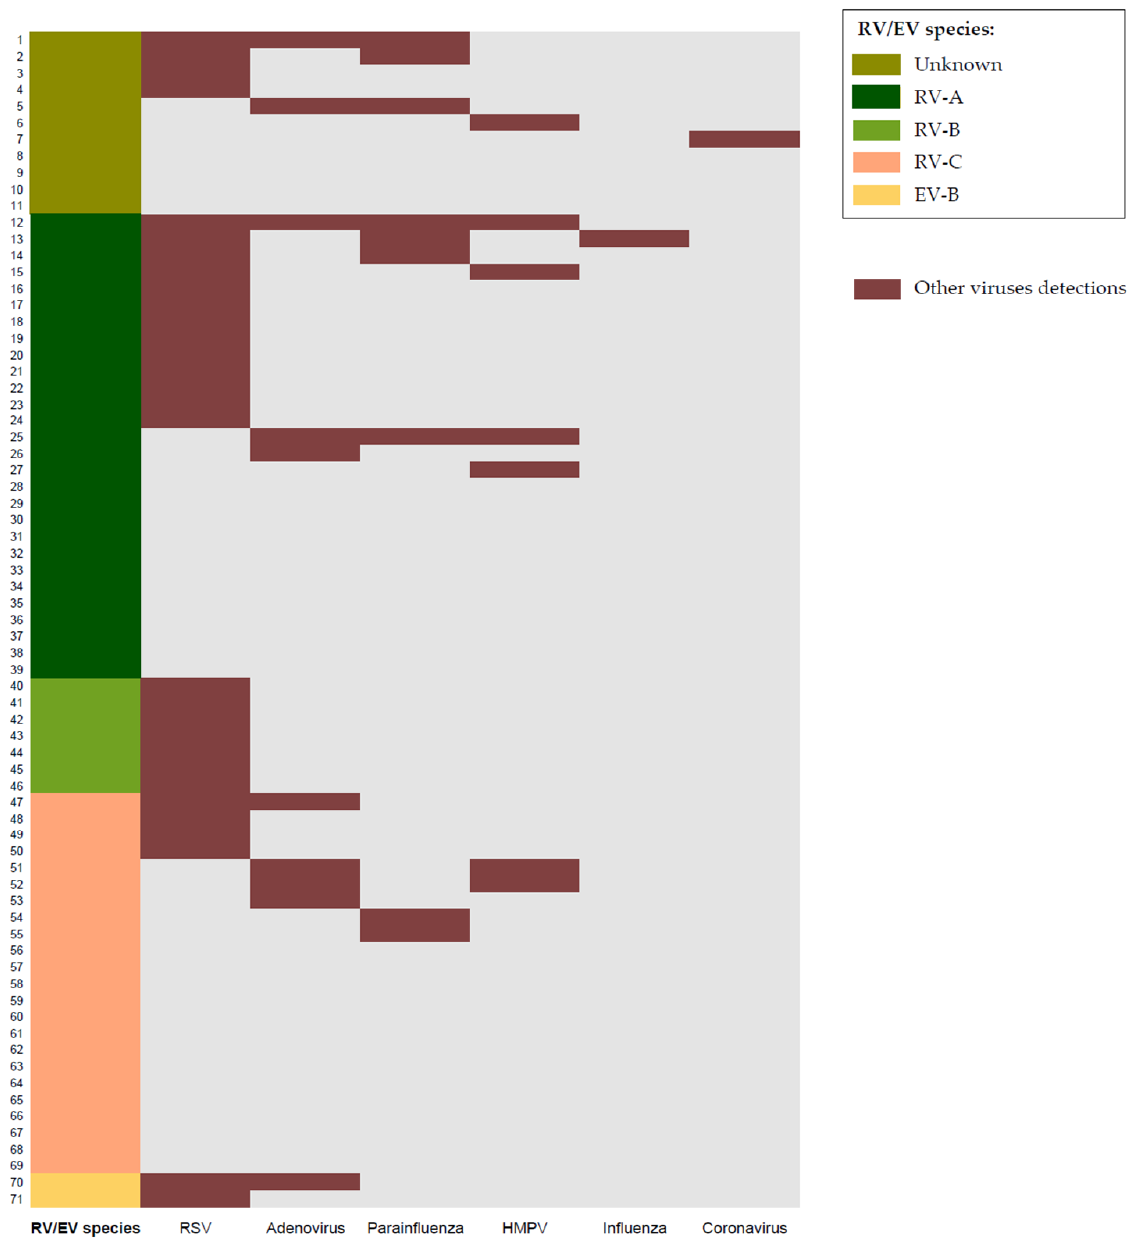
Figure 2. Viral detections and EV/RV species in each patient. MPV: human metapneumovirus; RSV: respiratory syncytial virus; RV/EV: rhinovirus/enterovirus.